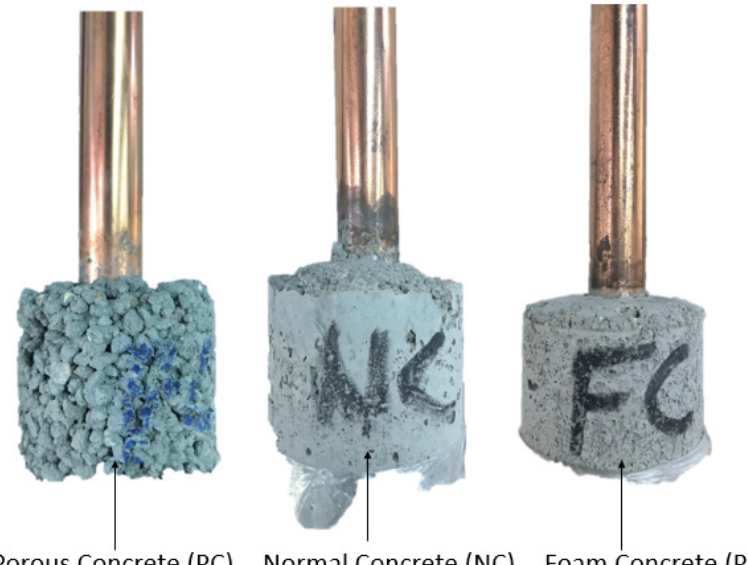
Figure 2. Finished products of ground electrodes.